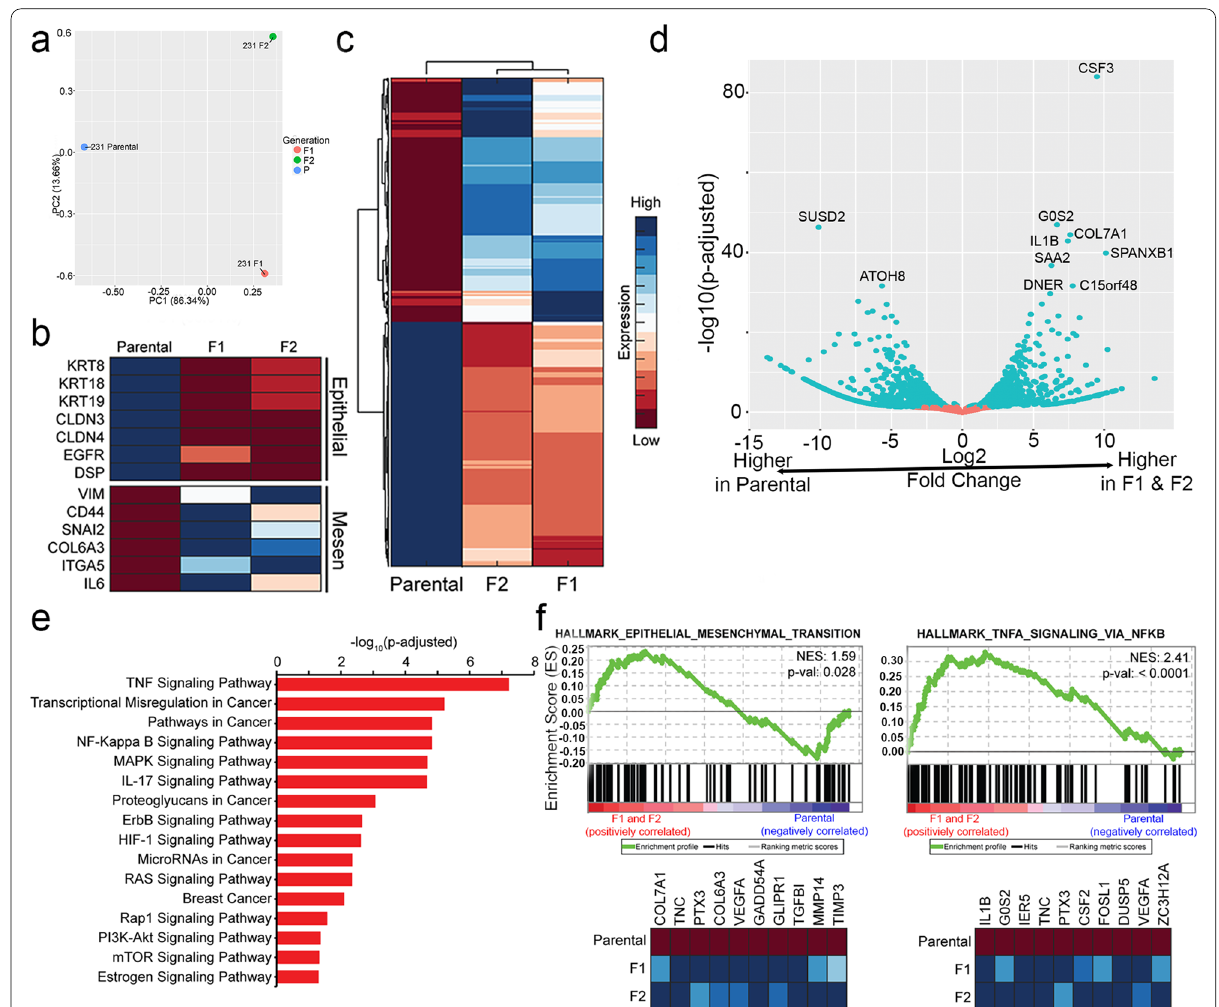
Fig. 2 RNA-sequencing of MDA-MB-231 parental, F1, and F2 populations reveals increased expression of EMT genes and metastasis-associated genes in F1/F2 compared to parental cell populations. a Principal-component analysis reveals transcriptomic differences between all three subpopulations. b A heatmap depicting RNA-sequencing expression of a select panel of epithelial and mesenchymal markers is shown. c A clustergram of the overall transcriptomic landscape of the parental, F1, and F2 populations. d A volcano plot depicting the most significantly upregulated and downregulated genes when comparing the F1 and F2 populations relative to the common parental control. e A KEGG analysis was performed, revealing enrichment of several important cancer-associated pathways in the F1 and F2 populations. f GSEA analysis identified enrichment of the hallmarks gene set Epithelial-Mesenchymal Transition and TNFα Signaling via NF-kβ, among other gene